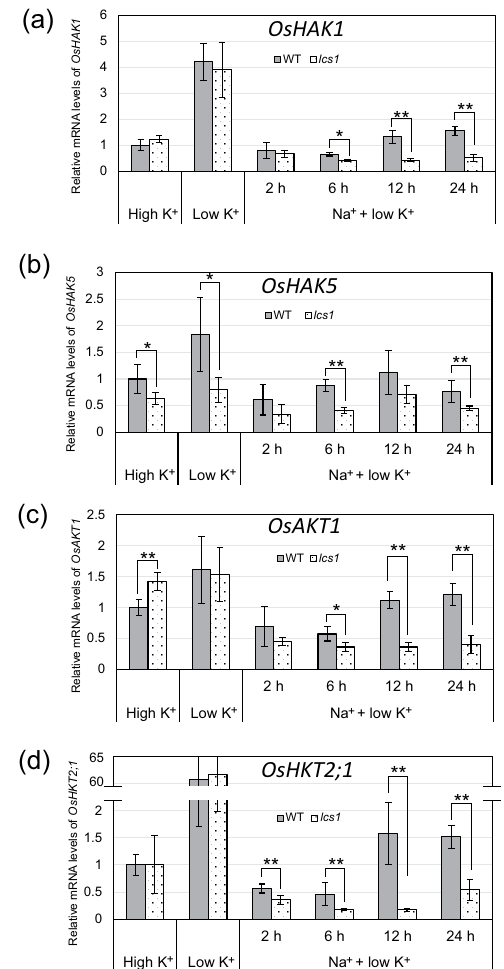
Figure 7. Relative mRNA levels of OsHAK1 ( a ), OsHAK5 ( b ), OsAKT1 ( c ), and OsHKT2;1 ( d ) in the roots of WT and lcs1 . Plants were treated with nutrient solution containing 1 mM K (high K + ) or 0.02 mM (low K + ) for 7 days. Then the plants grown at low K + were transferred into a solution with 10 mM Na + under low-K + conditions (Na + + low K + ) and treated for 2, 6, 12, or 24 h. Total RNA was extracted from the roots and the expression of each gene was determined by qRT-PCR. Actin 1 was used as an internal control. The expression of each gene in wild-type treated with high K + was defined as 1. Data are means ± SD of five biological replicates. ** P < 0.01, * P < 0.05 ( t